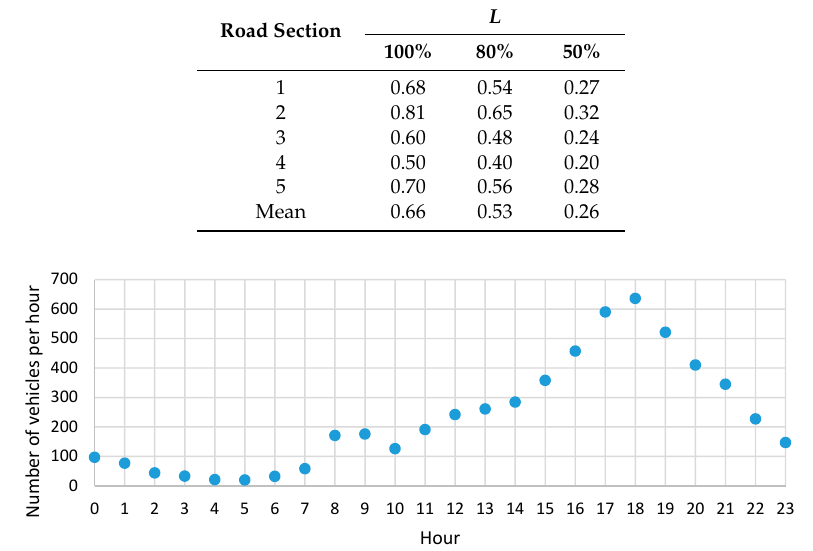
Table 7. Average road surface luminance ( L , cd/m 2 ) of different road sections (1–5) during the dimming schedule (100%, 80% and 50% power) applied for Vreta Gårds väg. The values for 100% were measured and those for 80% and 50% calculated assuming a linear relationship.